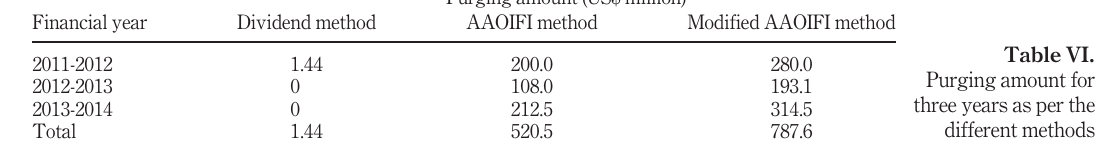
Table VI. Purging amount